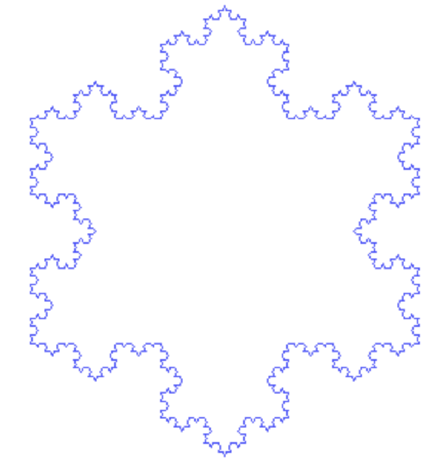
Figure 1. Figure of Koch snowflake curve depicting